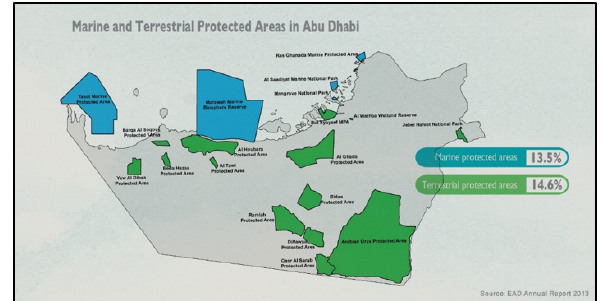
Figure 4: Map of Marine and Terrestrial Protected Areas of Abu Dhabi, (source: EAD